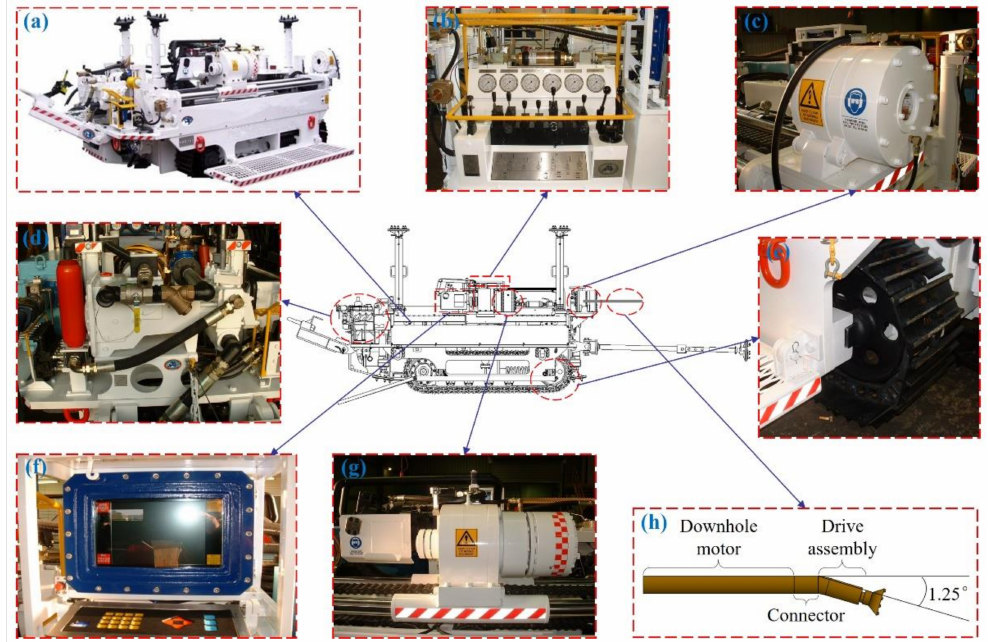
Figure 28. Construction equipment. ( a ) Overall drawing of drilling rig. ( b ) Operation console. ( c ) Front gripper. ( d ) Water pump. ( e ) Crawler. ( f ) Guidance system console. ( g ) Rotating